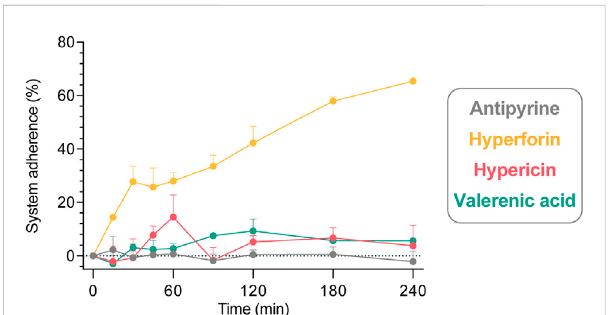
FIGURE 4 Adherence of study compounds in a 240 min system adherence test (circulation of study compounds through an empty perfusion chamber comprising only the maternal circuit). All compounds were tested individually in three independent experiments, and data are expressed as mean ± SD. Displayed is the percentage (%) of compound (ofinitiallyanalyzedconcentrationinthematernal sample) that adheres to the equipment: antipyrine ( − 2.2% ± 7.0%), hyperforin